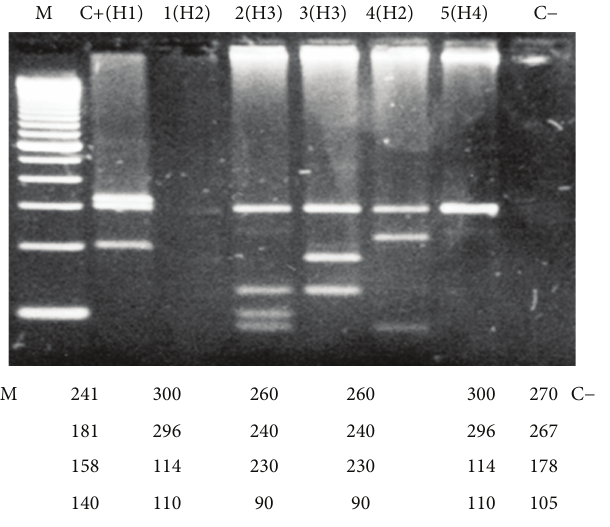
agarose gel 1000, stained %